Question: Give a one-sentence summary of this figure.
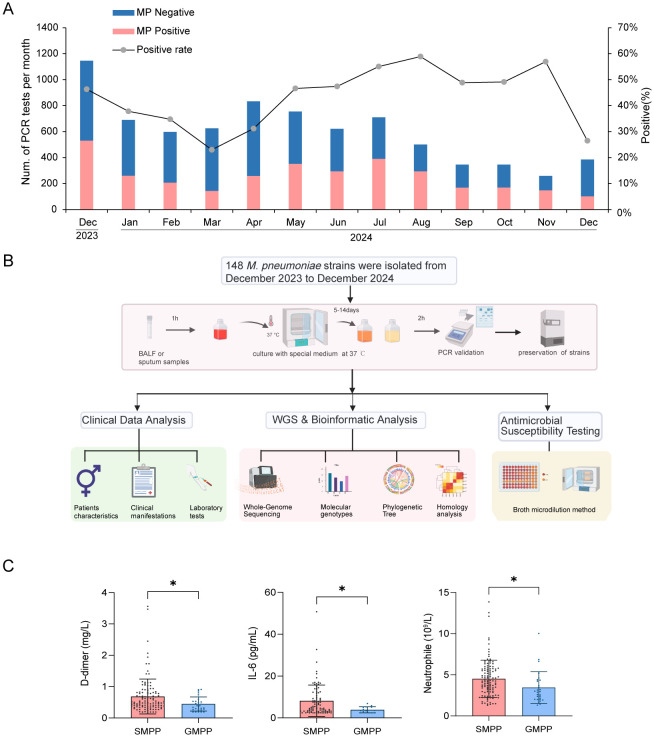
Answer: Epidemiological trends of Mycoplasma pneumoniae strains from pediatric patients with suspected respiratory infections. (A) Monthly average positive rate and number of PCR testing for suspected M. pneumoniae infections at Shanghai Children’s Hospital (2023.12–2024.12). (B) Study workflow. (C) Differences in key laboratory indicators between SMPP and GMPP group. * P < 0.05 (Student’s t test).